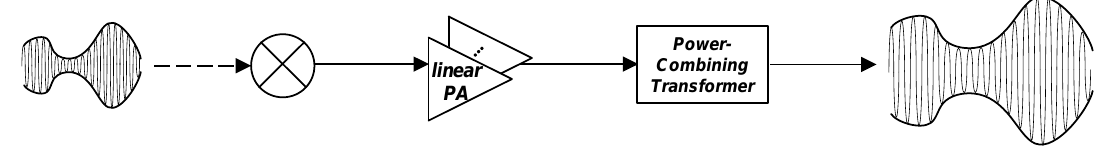
Figure 1. Power amplifier with a power-combining transformer in a transmitter.